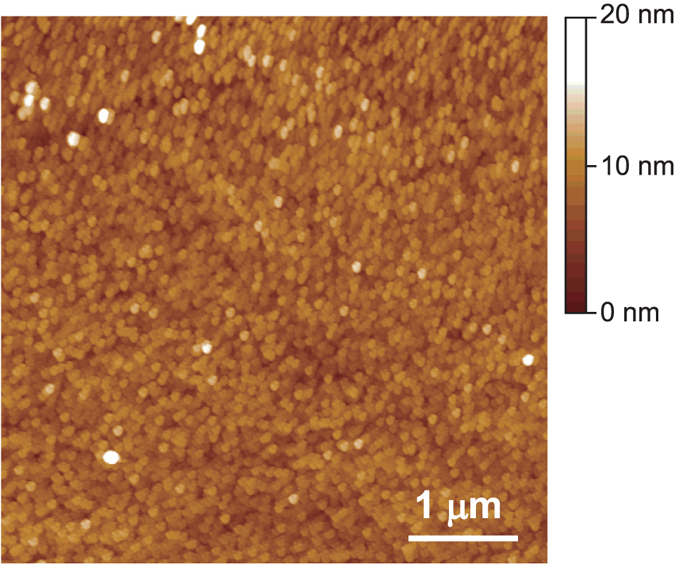
Atomic force microscope image of an In0.30Ga0.70N film grown on an a-HfO2-coated glass substrate.The root-mean-square surface roughness was 1.8 nm, and the average grain size was ~10 nm.